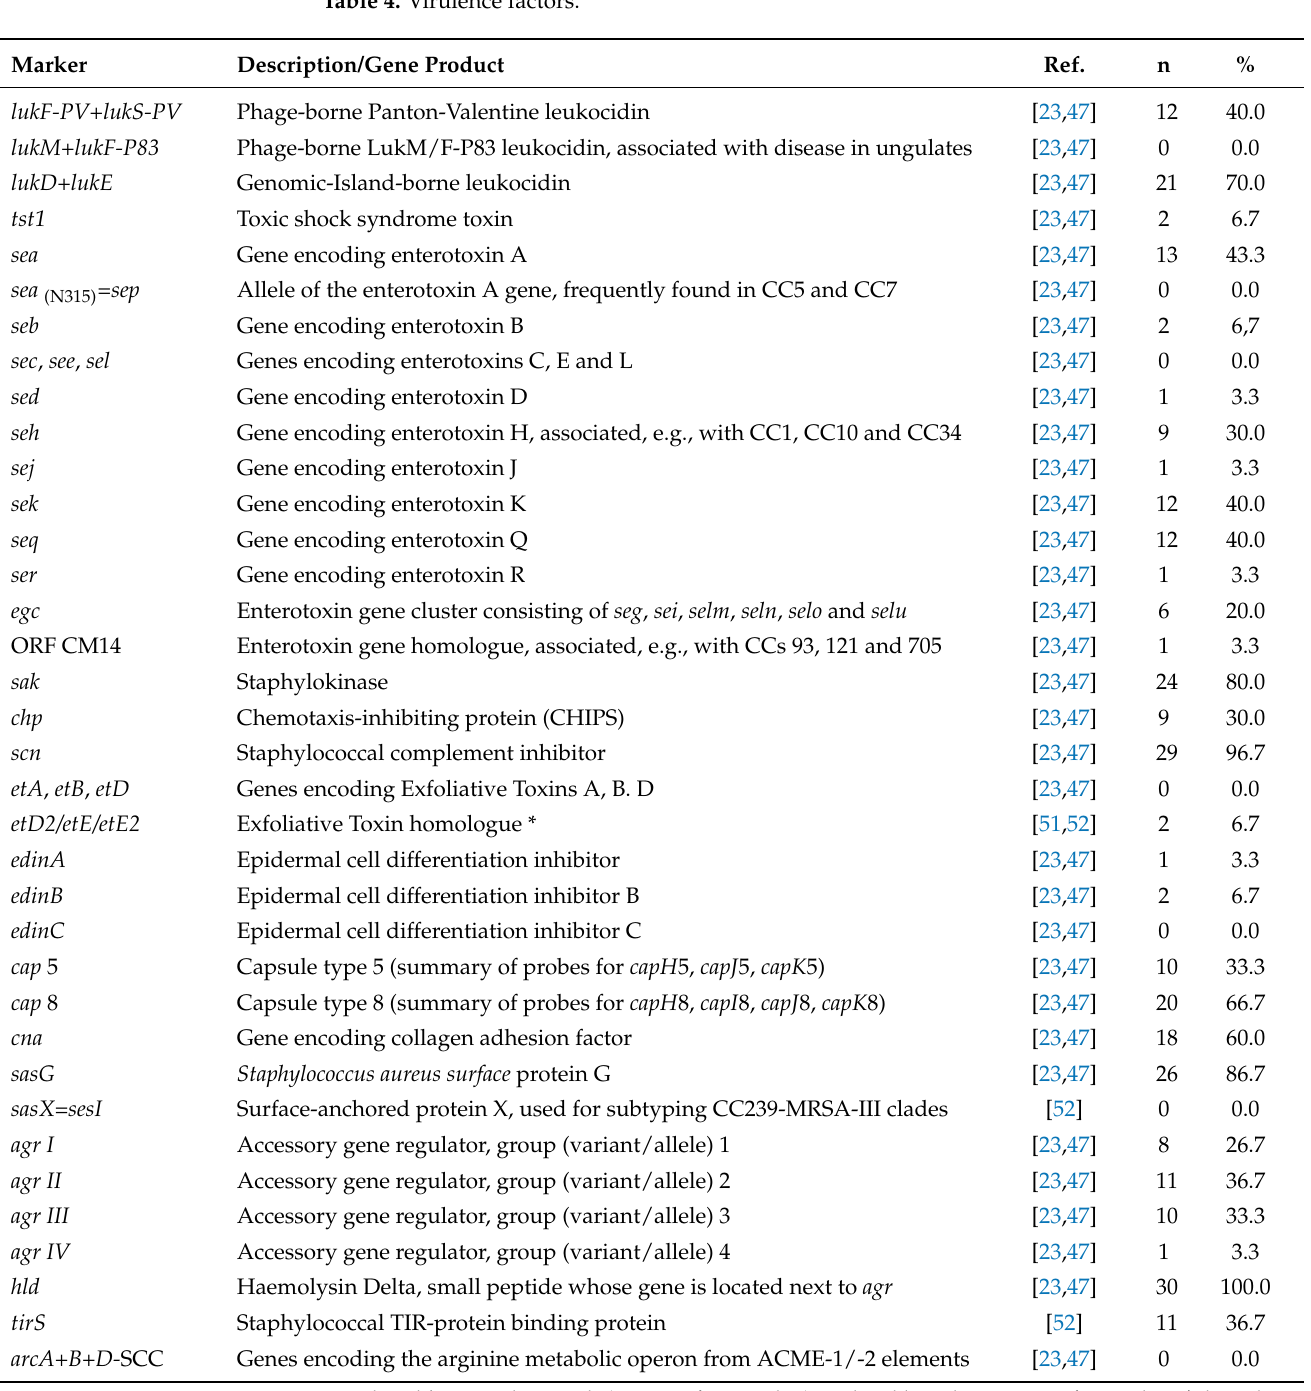
Table 4. Virulence